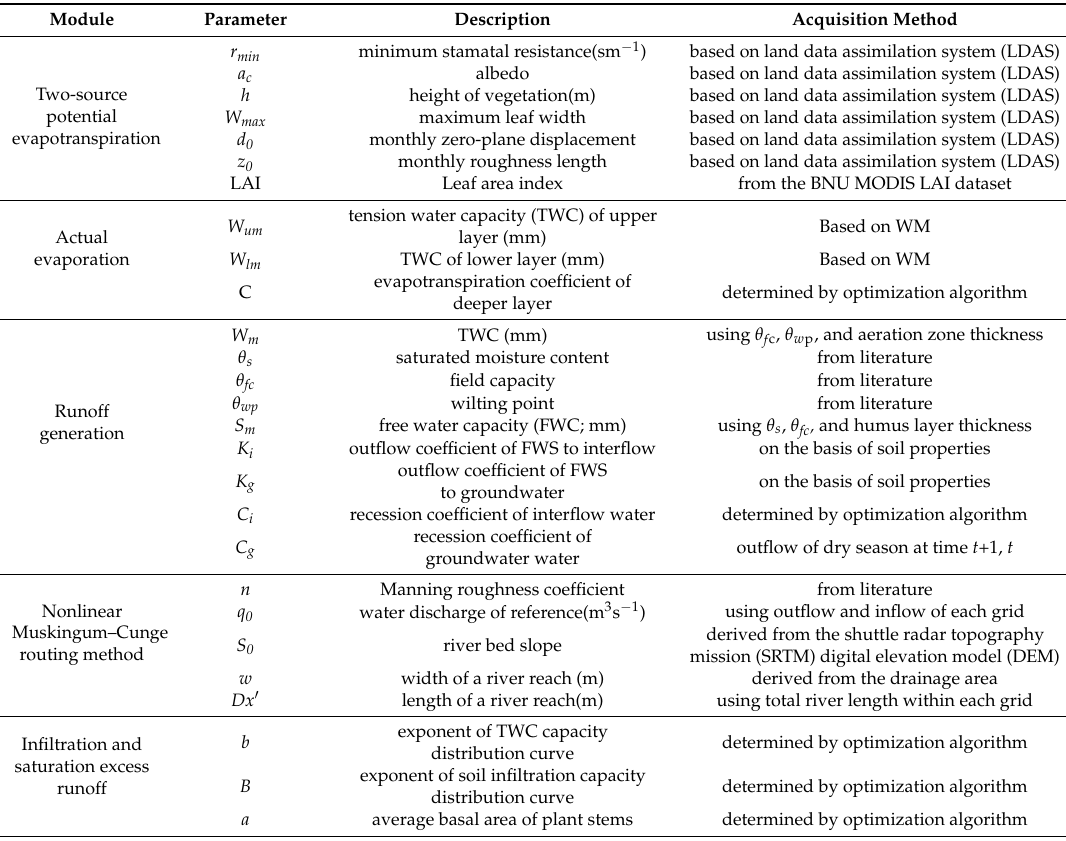
Table 2. The description and acquisition methods of all model